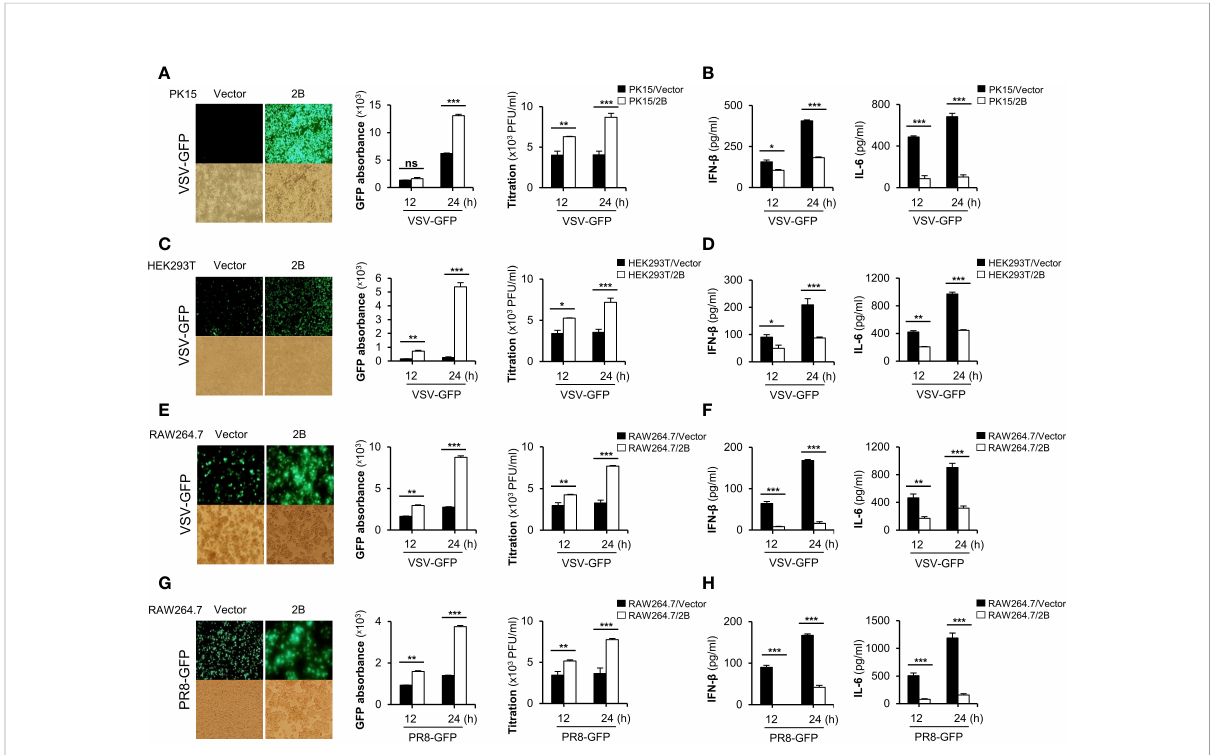
FIGURE 1 FMDV 2B negatively regulate RNA virus-mediated innate immune responses. PK-15 cells (A, B) and HEK293T cells (C, D) were transiently transfected with the control vector or FMDV 2B and infected with VSV-GFP. GFP expression, GFP absorbance, and virus titer was taken at 12 and 24 hpi (A, C) . The concentration of secreted IFN- b and IL-6 in supernatants was determined at 12 and 24 hpi by ELISA (B, D) . Control vector and FMDV 2B stably expressing RAW264.7 cells were infected with VSV-GFP (E, F) and PR8-GFP (G, H) . GFP expression, GFP absorbance, and virus titer was taken at 12 and 24 hpi (E, G) . The concentration of IFN- b and IL-6 secreted in supernatants were determined at 12 and 24 hpi by ELISA (F, H) . Results representative of at least two independent experiments, each with similar results, and the values are expressed as mean ± SD of three biological replicates. Student ’ s t-test; *p < 0.05; **p < 0.01; ***p < 0.001; ns, not signi fi